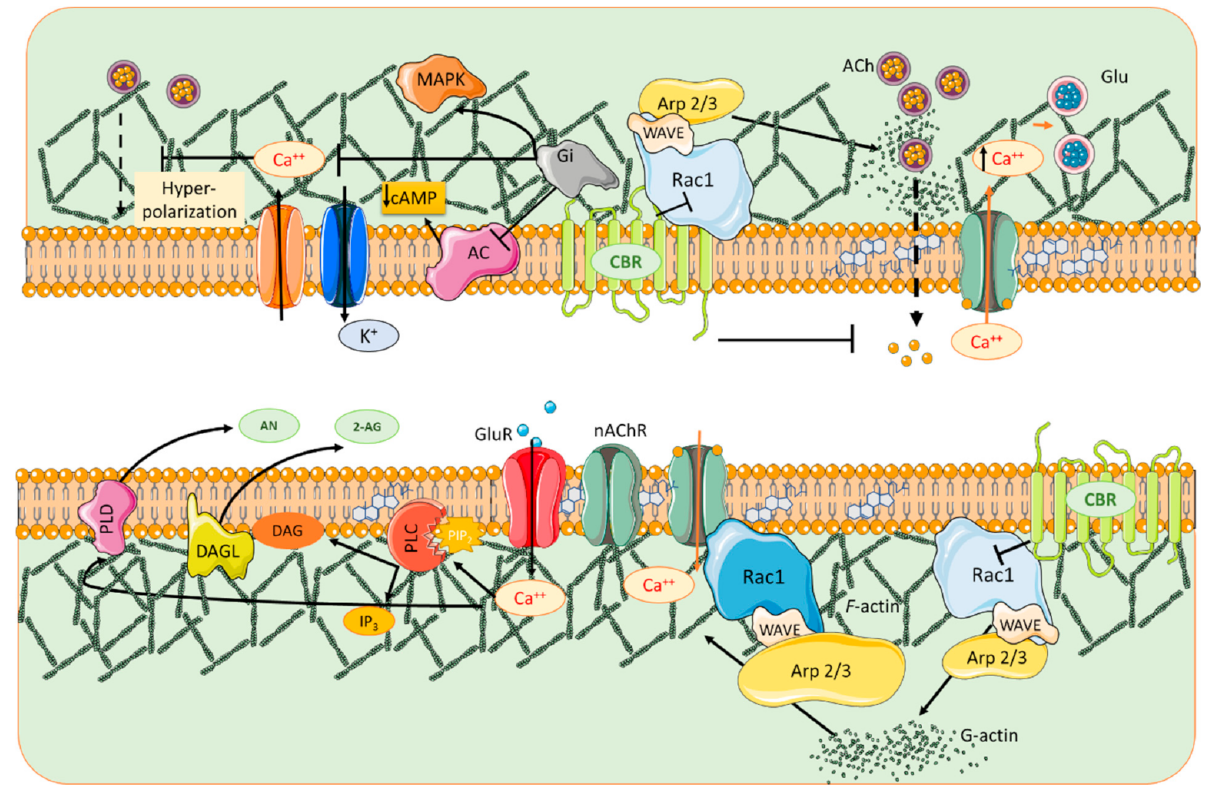
Figure 3. Schematic diagram of a vomposite synapse summarizing the pre- and postsynaptic components